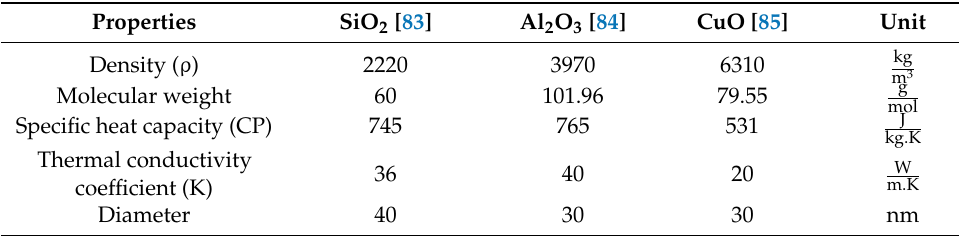
Table 6. Nanoparticle properties.